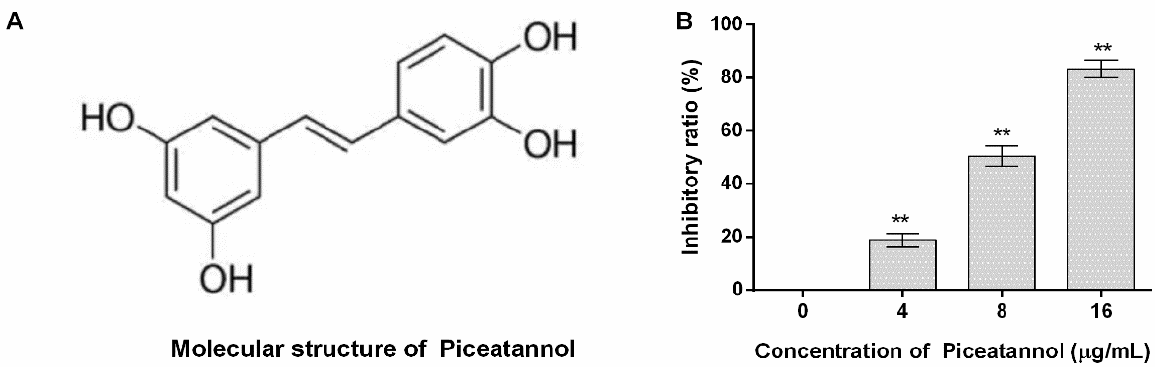
Figure 1. The molecular structure of piceatannol and the inhibitory effects of the compound against PFO. ( A ) The molecular structure of piceatannol. ( B ) Piceatannol inhibits the pore-forming activity of PFO. n = 3, ** indicates p ≤ 0.01.